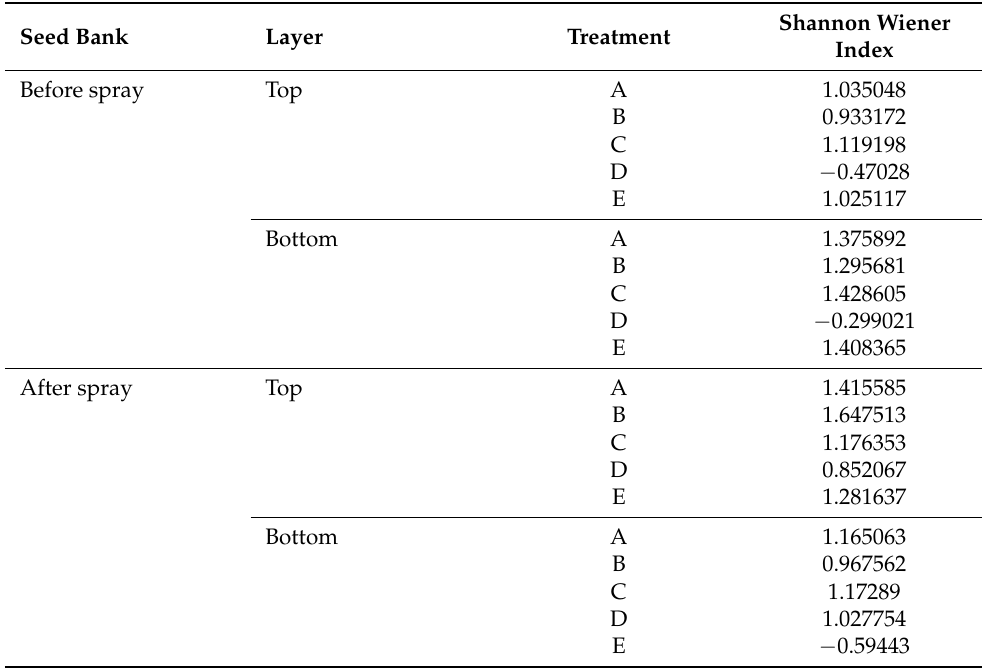
Table 2. Shannon—Wiener index for different treatments metsulfuron-methyl (A), fluroxypyr/ aminopyralid (B), triclopyr/picloram/ aminopyralid (C), bromoxynil (D), and Control (E).